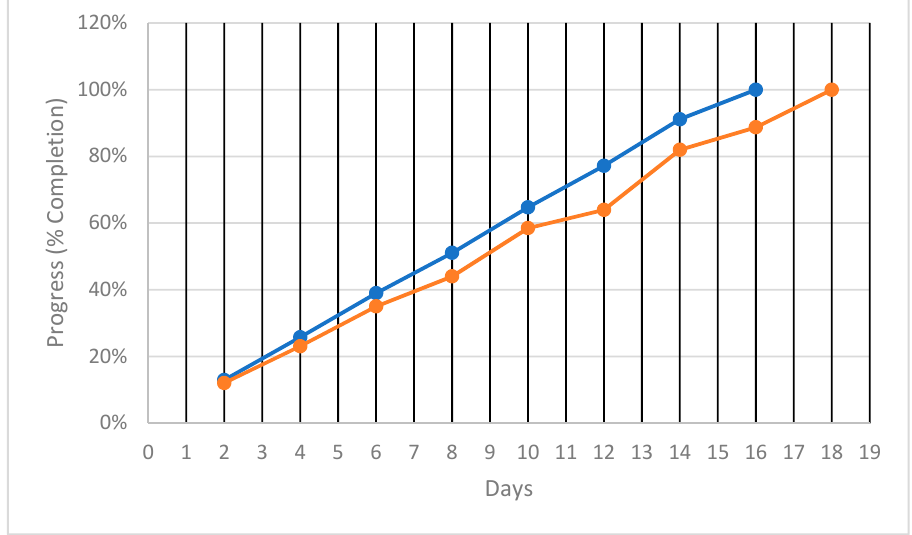
Figure 15. Percent completion of the project with initial vs. updated prediction.